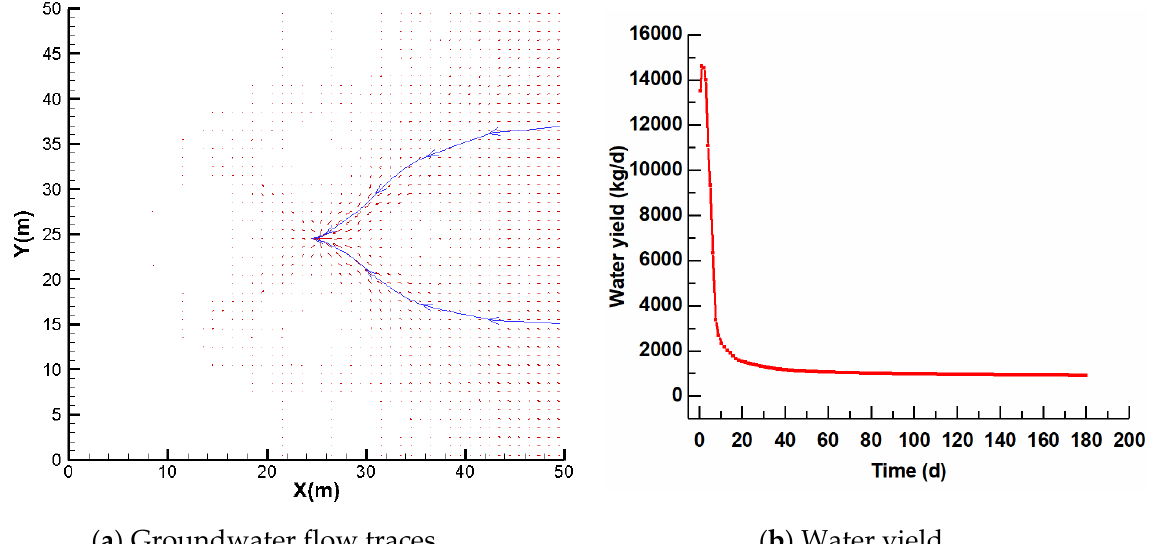
Figure 6. Groundwater flow traces and water yield of the production well.